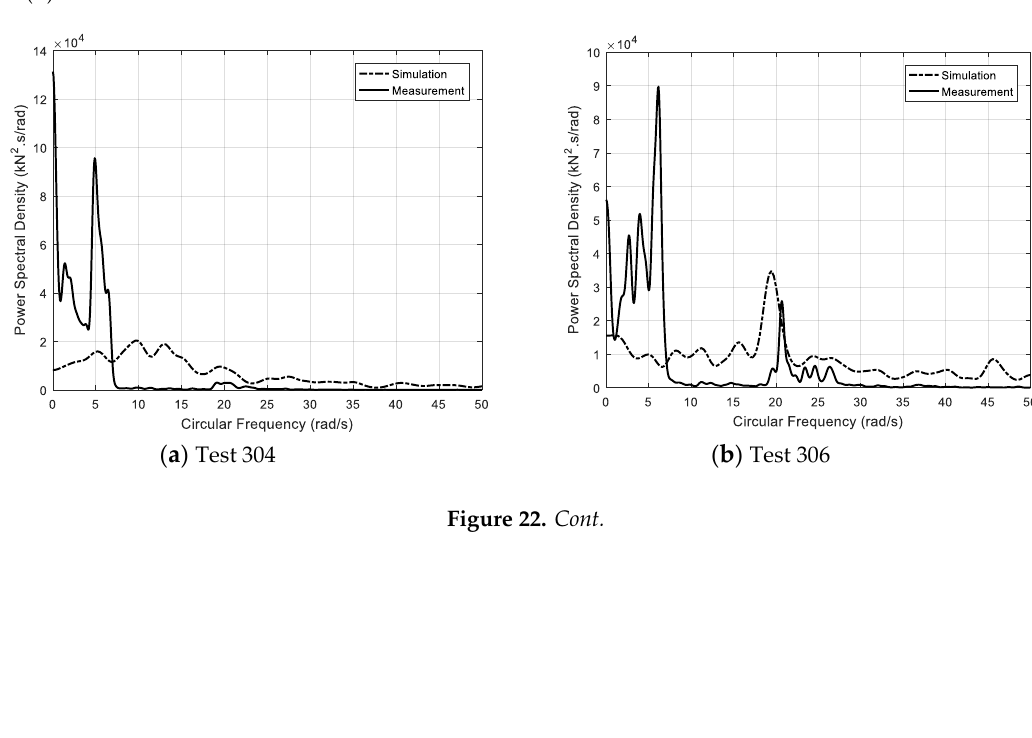
Figure 21. Weibull fitting of the simulated and measured peaks for tests ( a ) 304, ( b ) 306, ( c ) 404 and ( d ) 406.